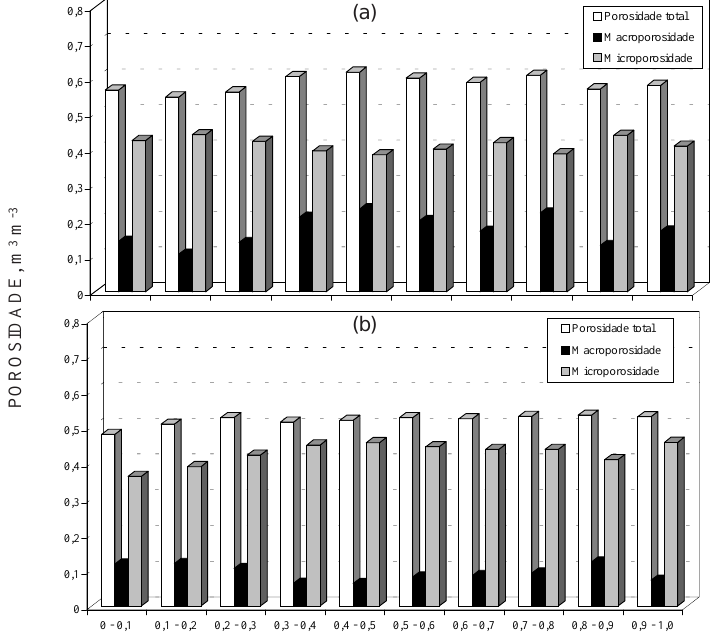
Figura 2. Porosidade total, macroporosidade e microporosidade do Latossolo Amarelo distrófico (a) e do Latossolo Vermelho distroférrico típico (b).